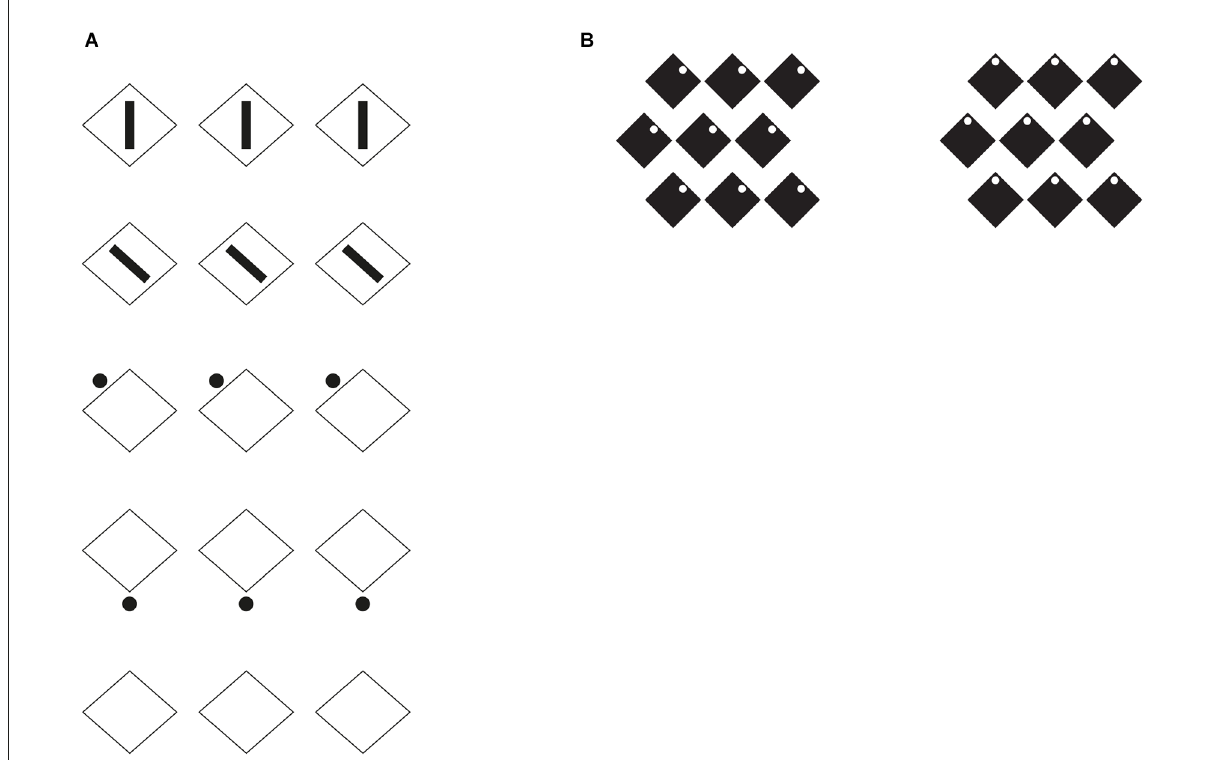
FIGURE7 (A) Diamonds (first and fourth rows), rotated squares (second and third rows), control (fifth row). (B) Rotated squares (left), diamonds